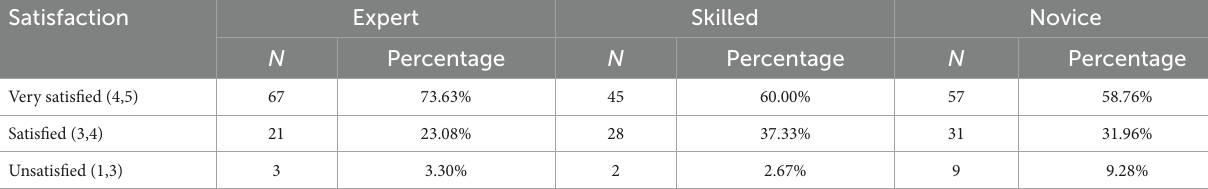
TABLE 9 Satisfaction with expert, skilled, and novice teachers in terms of Content ( N = 263).